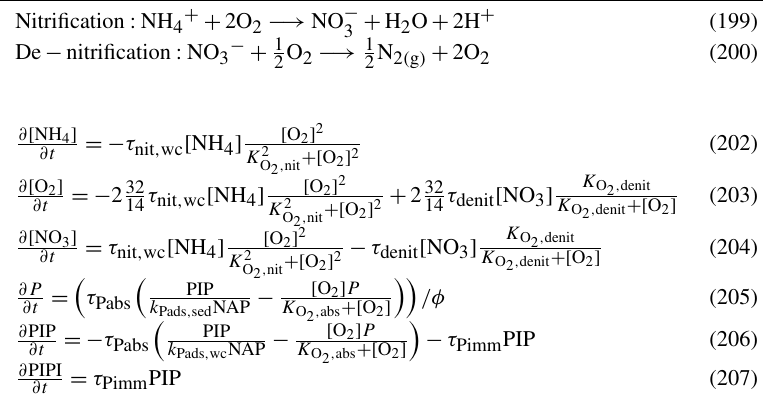
Table 36. Equations for the sediment inorganic chemistry.